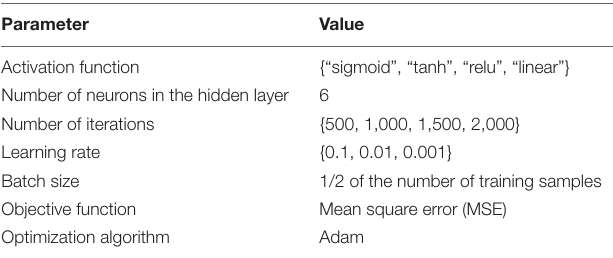
TABLE 2 | Hyperparameter selection of Bayesian bidirectional long short-term memory neural network (BiLSTM) model. Parameter Value Activation function